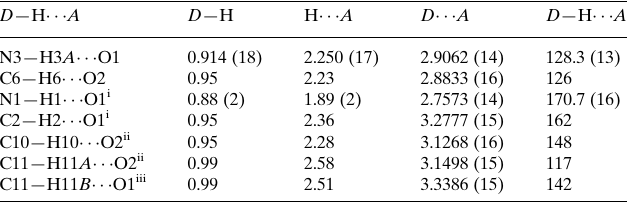
Hydrogen-bond geometry (A˚ , (cid:2)